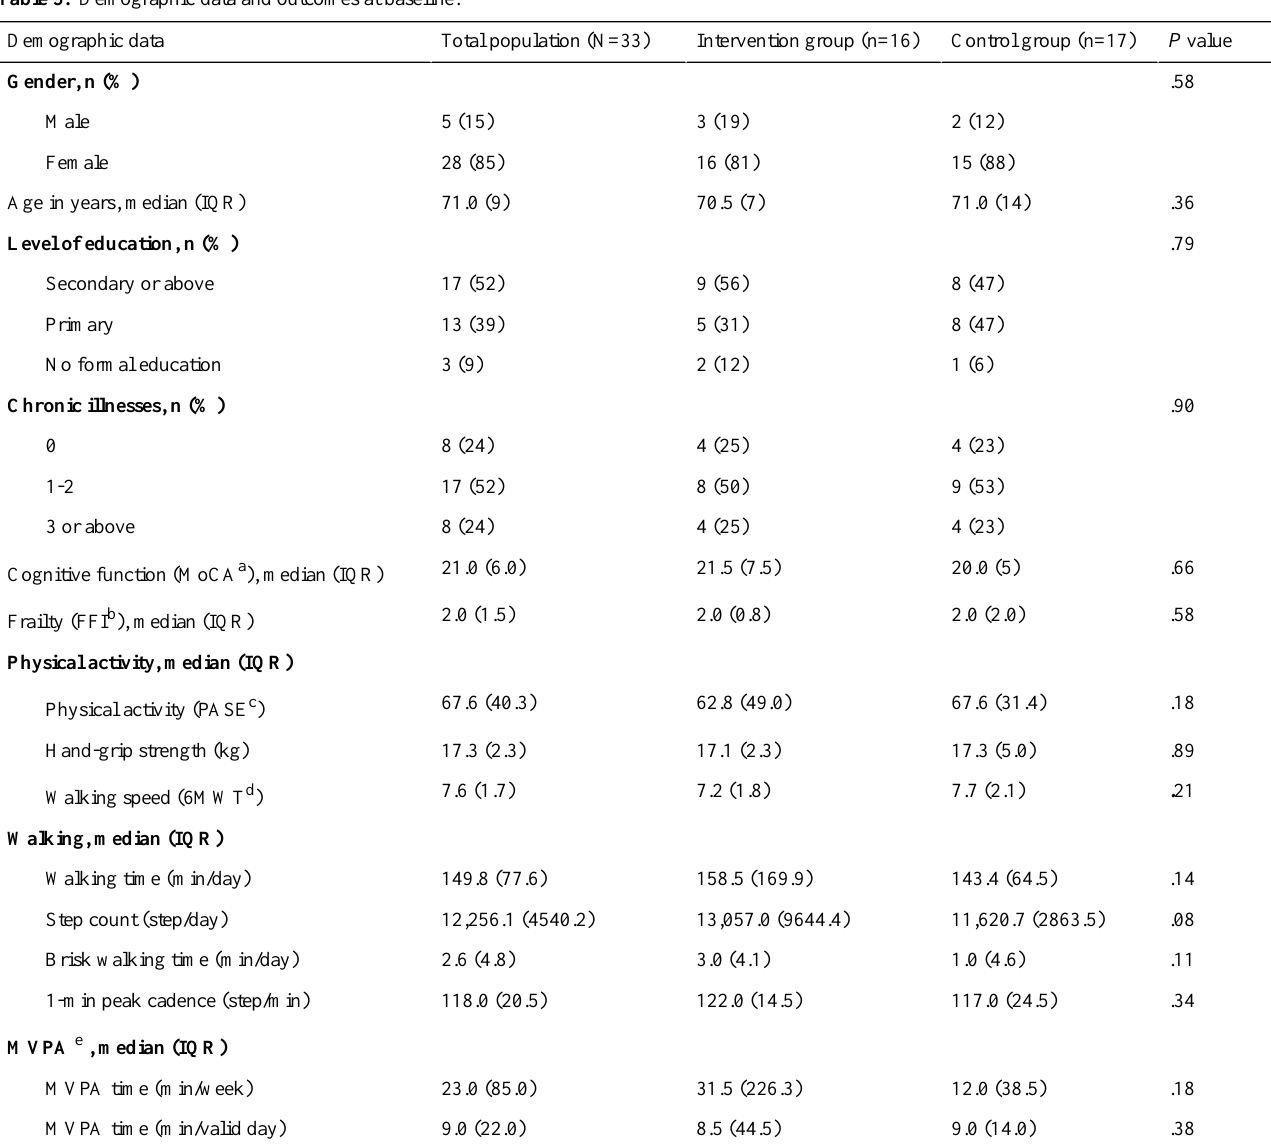
Table 5. Demographic data and outcomes at